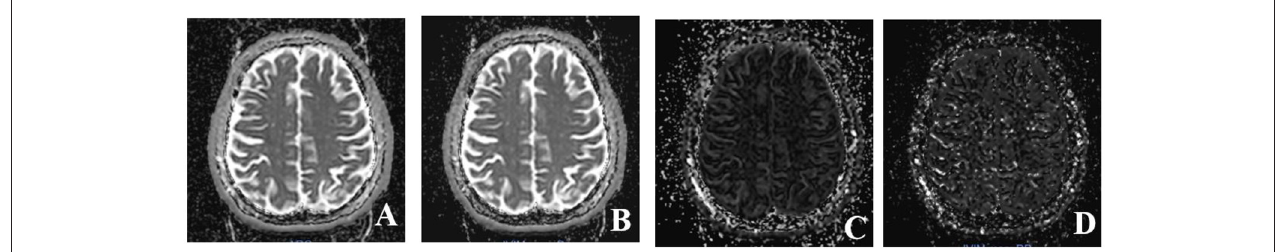
FIGURE 1 | Four parameter maps of intravoxel incoherent motion MRI imaging after post-processing. (A) Image of apparent diffusion coefficient (ADC) value. (B) Image of D value. (C) Image of f value. (D) Image of D *